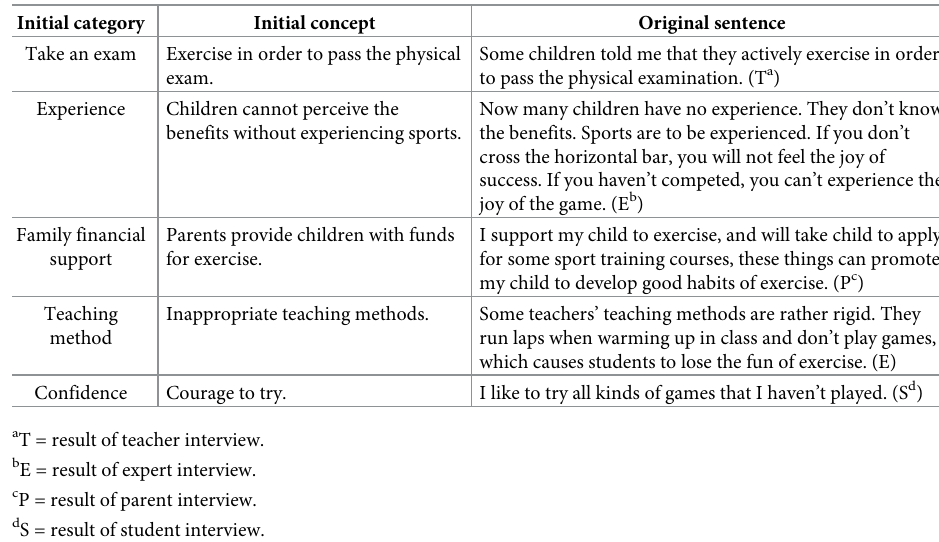
Table 3. Open coding results